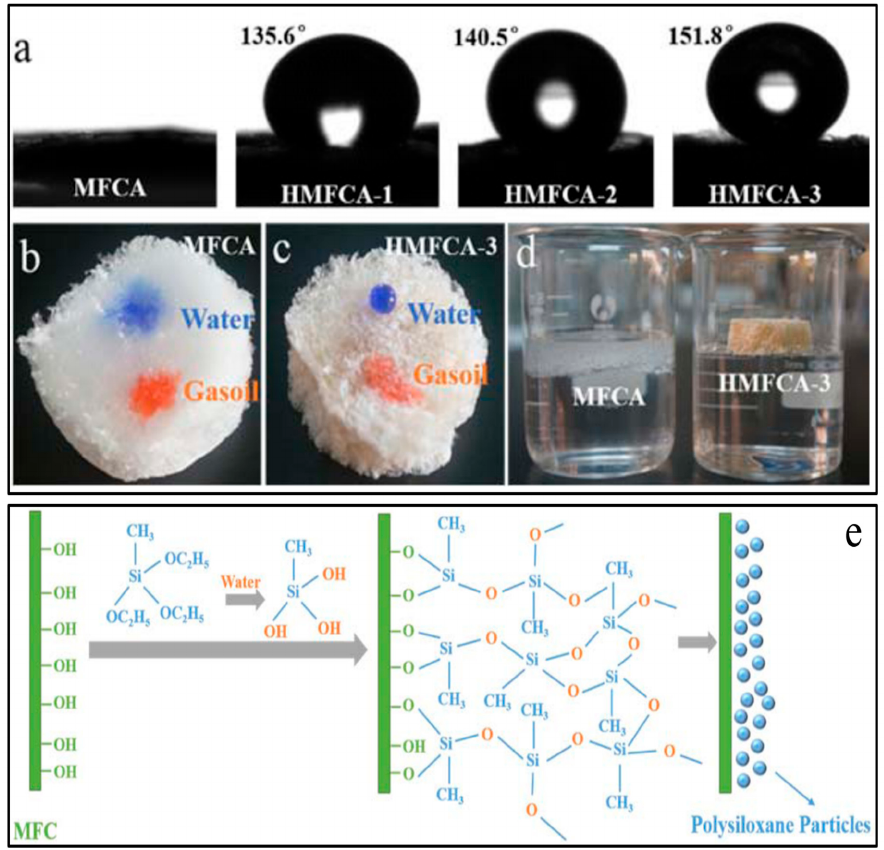
Figure 4. ( a ) Contact angle measurement of unmodified and modified micro fibrillated cellulose aerogel (MFCAs) with 1, 2 and 3 mL methyltriethoxysilane (MTES) concentrations. ( b , c ) Water/oil selectivity of unmodified MFCA and modified MFCA with 3 mL of MTES with both water and oil absorbed in the unmodified MFCA while only oil is absorbed in the modified MFCA. ( d ) Modified MFCA floating on water while unmodified MFCA sinking into water. ( e ) Schematic representation of silinization grafting of methyltriethoxysilane (MTES) onto micro fibrillated cellulose (MFC). Reproduced with permission from Zhou et al. [51]. ACS publications copyright ©